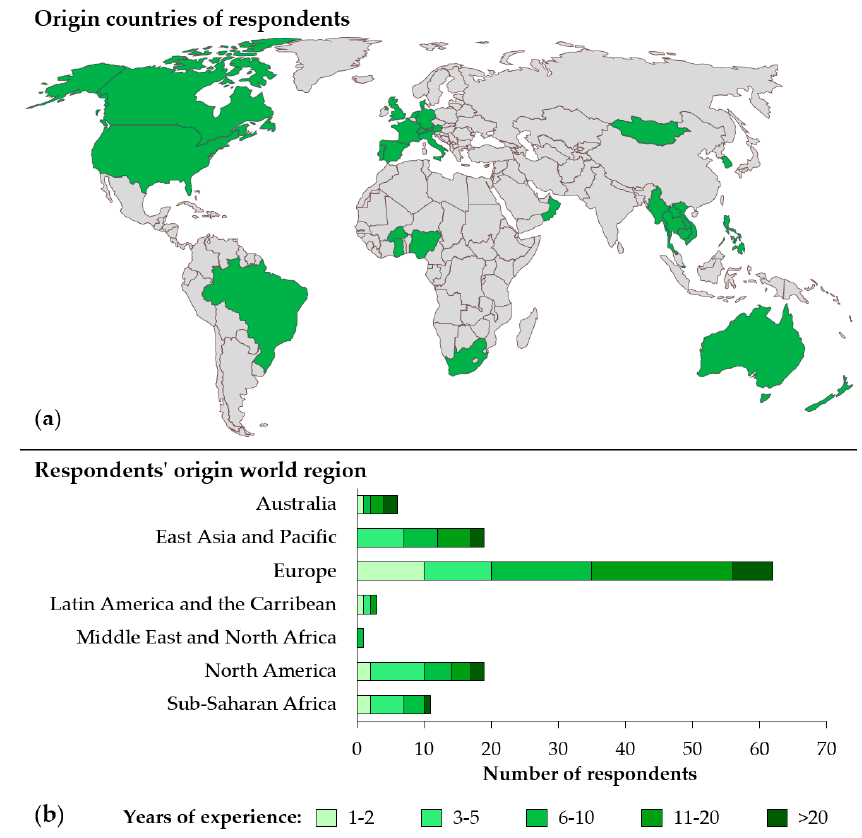
Figure 1. ( a ) Origin countries of respondents; and ( b ) the number of respondents per region with corresponding years of HIA practice experience.